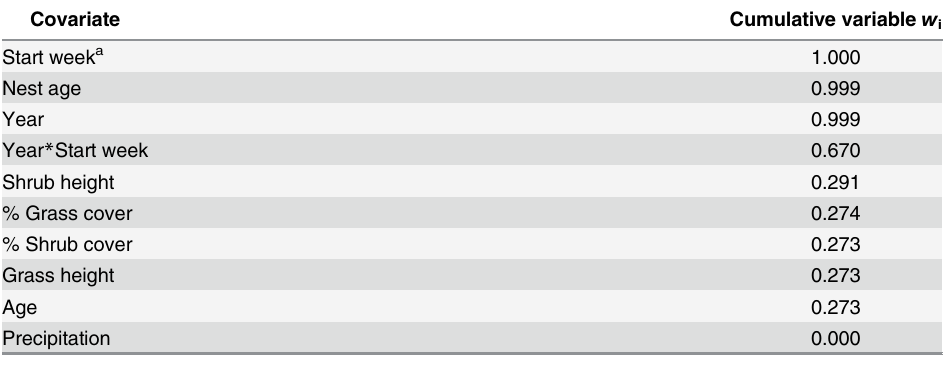
Table 2. Relative variable importance (cumulative Akaike Information Criterion (AIC c ) weights — w i ) for Gunnison Sage-Grouse nest success analysis for two populations in southwest Colorado, USA from 2005 –